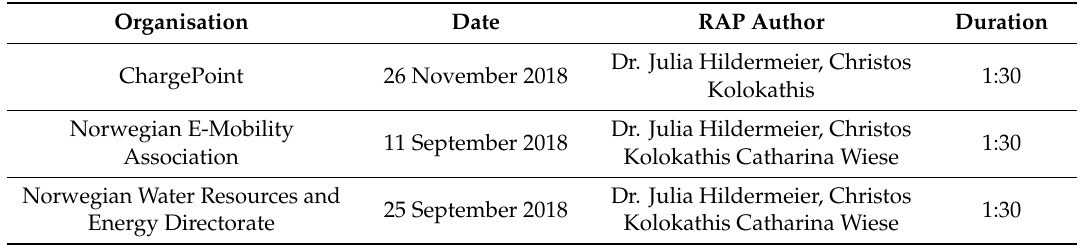
Table A1. Stakeholder